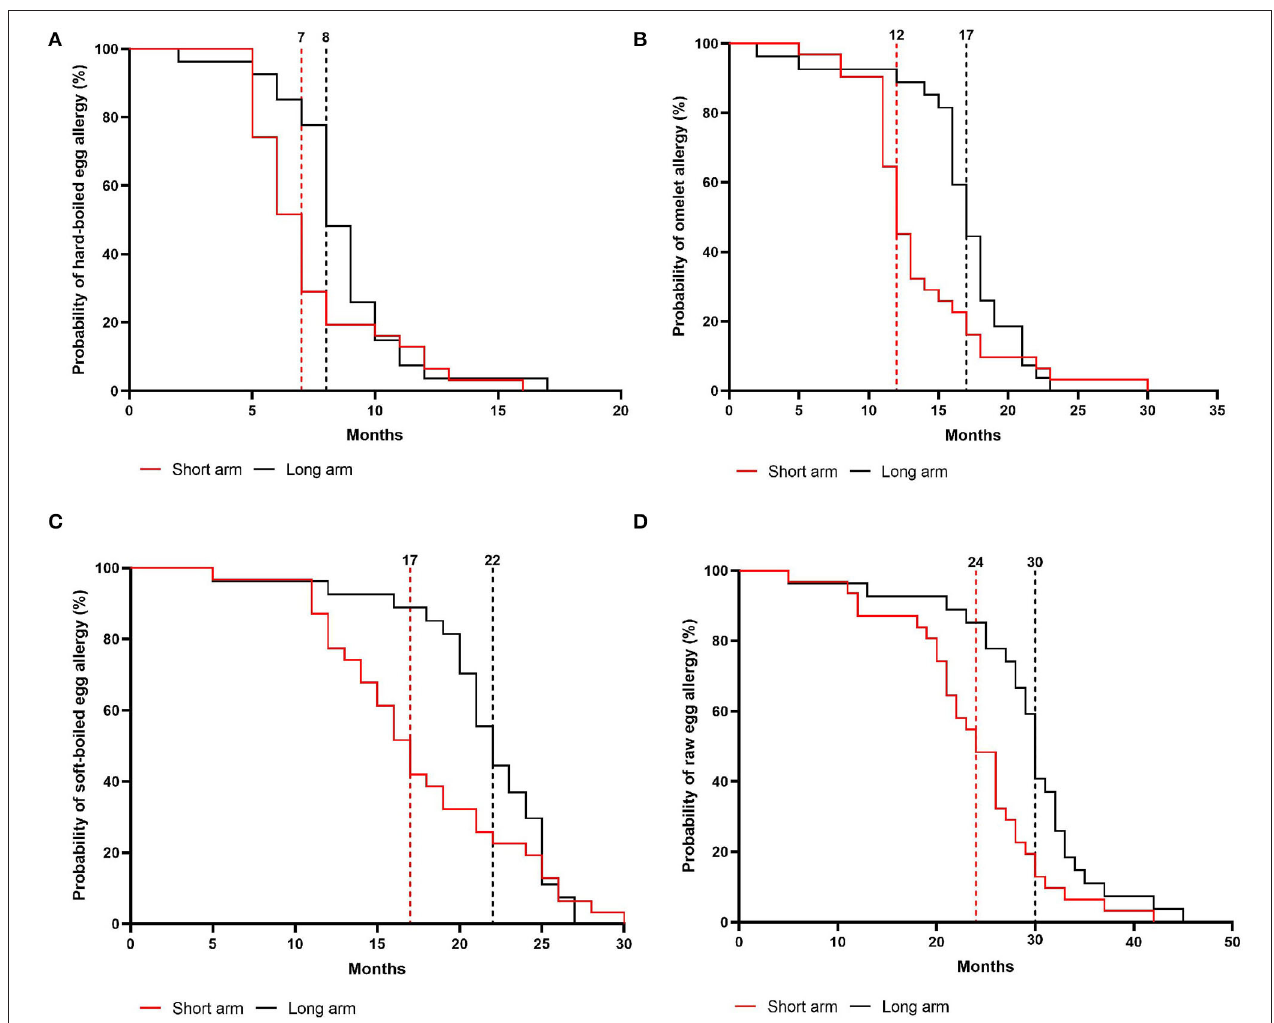
FIGURE 5 | Cox regression analysis of the step-wise egg-tolerance induction over time in the per-protocol group. (A) hard-boiled egg resolution over time (SA: n = 31, LA: n = 27, P = 0.08) (B) omelet resolution over time (SA: n = 31, LA: n = 27, P = 0.02) (C) soft-boiled egg resolution over time (SA: n = 31, LA: n = 27, P = 0.12) (D) raw egg resolution over time (SA: n = 31, LA: n = 27, P = 0.005). SA, short arm protocol; LA, long arm